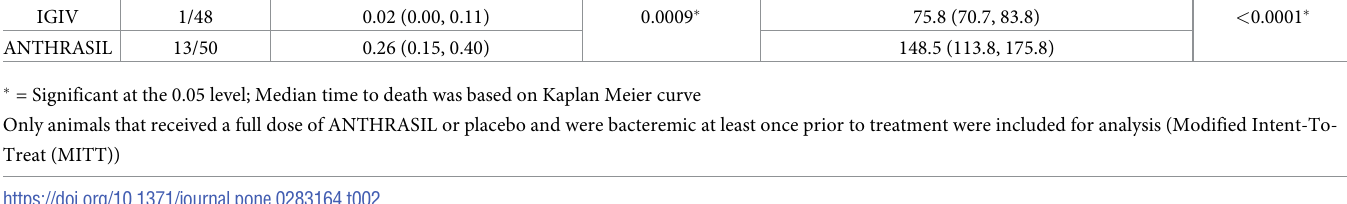
Proportion of Survivors (95% Confidence Interval)